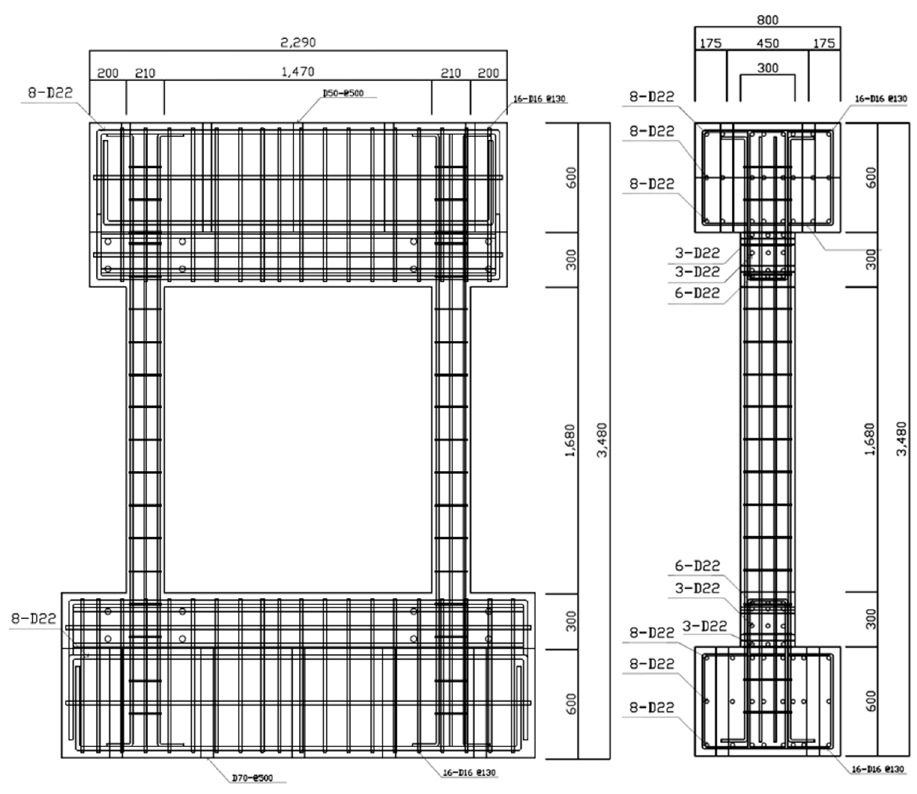
Figure 4. Details of the control specimen. Table 3. Summary of the specimens used in this study. RCFR: Control specimen without CFCC